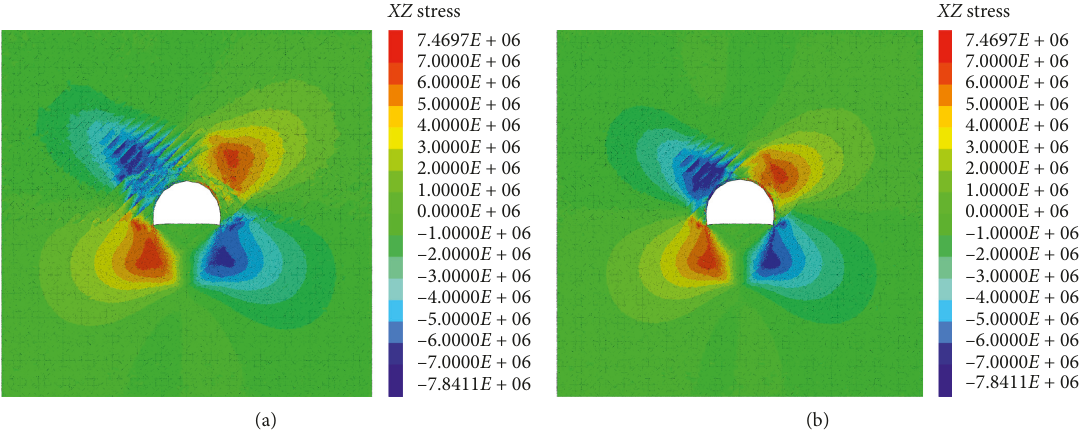
Figure 17: Shear stress nephrogram of the surrounding rock. (a) Surrounding rock shear stress nephrogram with the steel arch support. (b) Surrounding rock shear stress nephrogram with the anchor cable